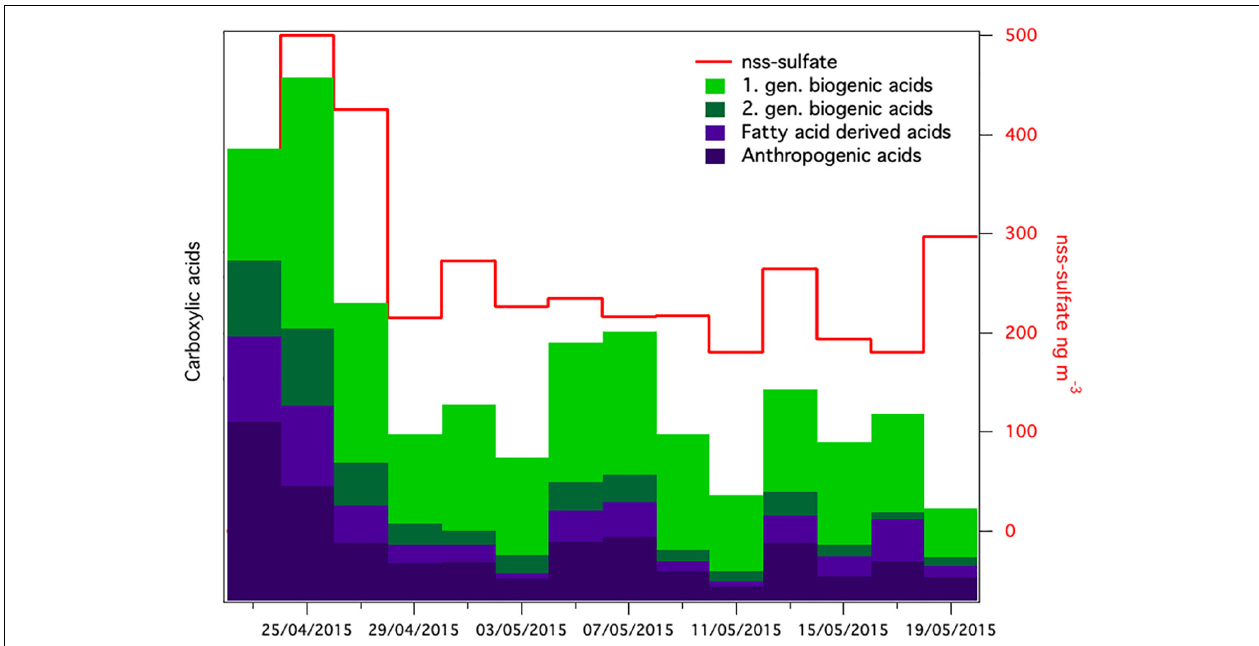
FIGURE 7 | Relative concentrations of groups of carboxylic acids together with non-sea-salt sulfate [nss-sulfate in aerosol samples (nss-sulfate was not analyzed in the first